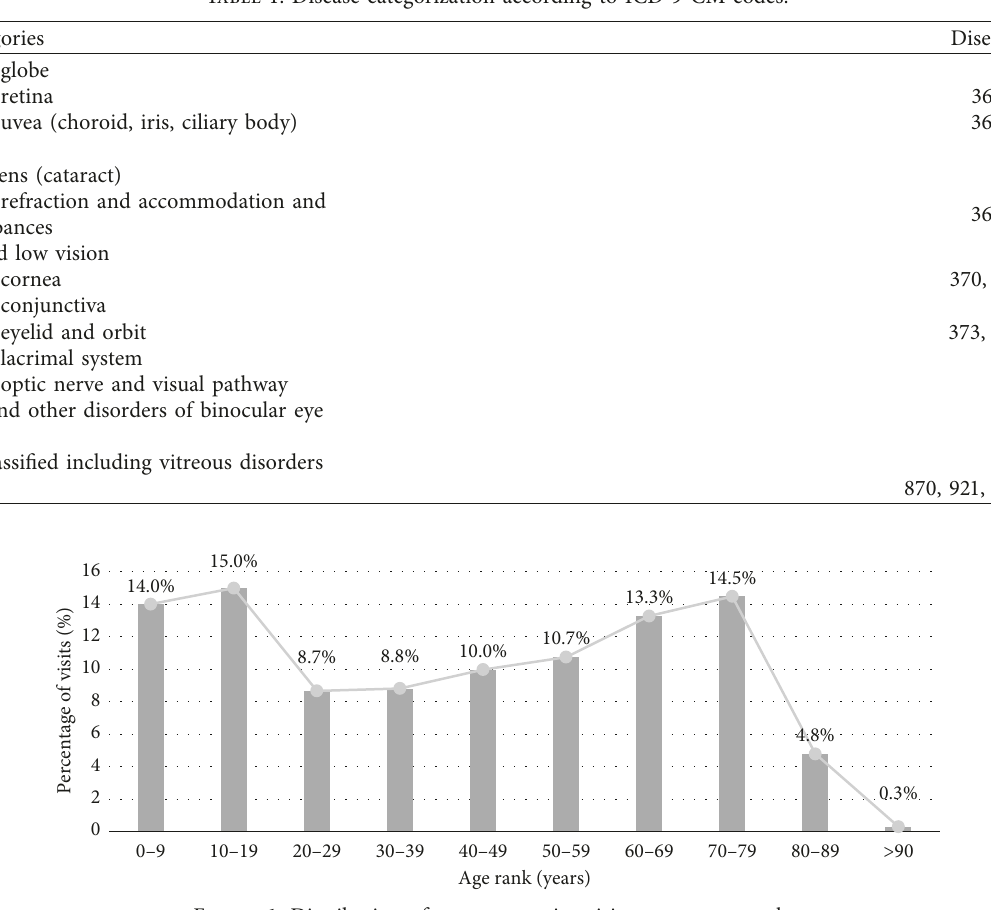
Table 1: Disease categorization according to ICD-9-CM codes.